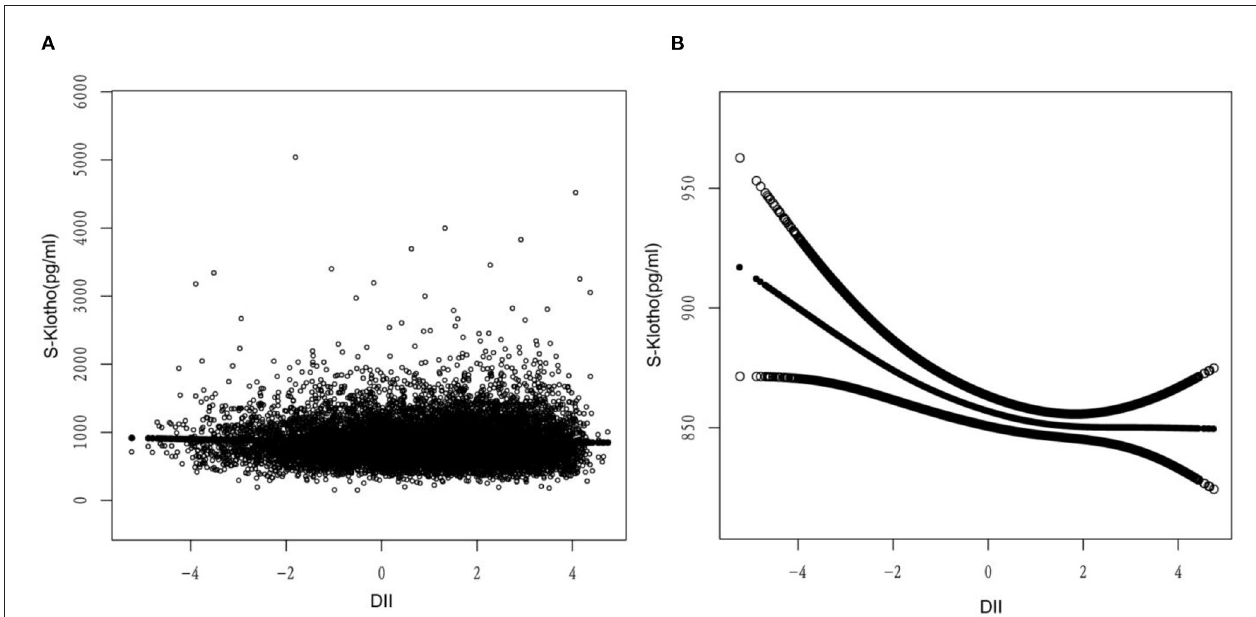
FIGURE 1 | Relationship between DII and S-Klotho. (A) Each black dot represents A sample. (B) Solid lines represent smooth curve fitting between variables. The black dotted line shows a 95% confidence interval (CI) for the fit. They adjusted for energy intake, age, sex, race, body mass index (BMI), use of medication, and systolic and diastolic blood pressure.